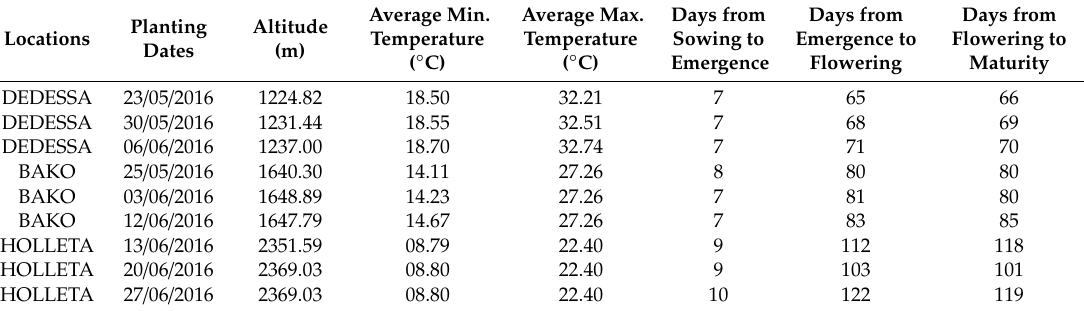
Table 3. Summary of the number of days from sowing to emergence, emergence to flowering, and flowering to maturity, respectively, for BH660 type hybrid maize variety for 3 planting dates in 5 locations of Ethiopia.